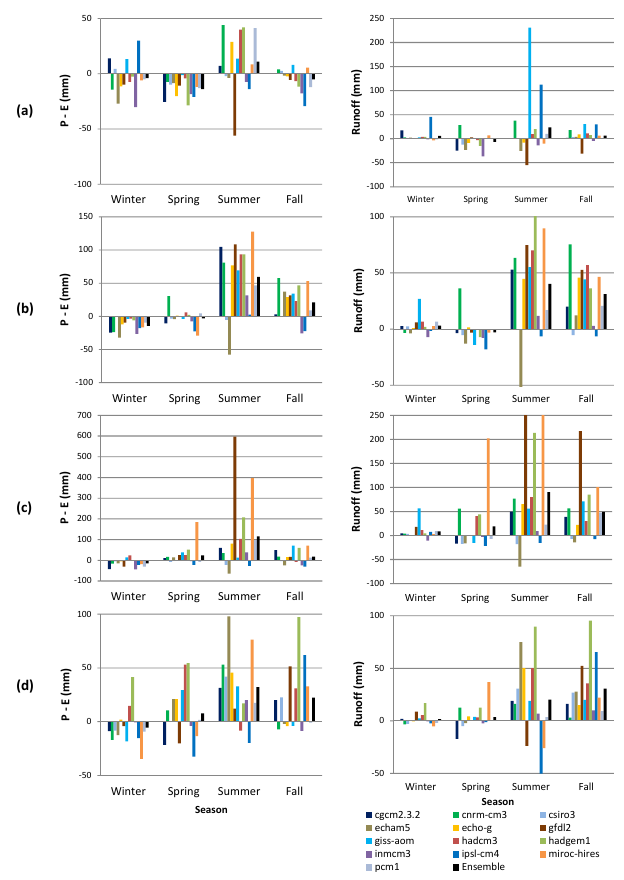
Fig. 8. Intra-annual changes in P − E (left) and R (right) for the 21st Century Climate (2061–2100) with respect to 20th Century Climate (1961–2000) for the basins, (a) Indus, (b) Ganges, (c) Brahmaputra, (d)